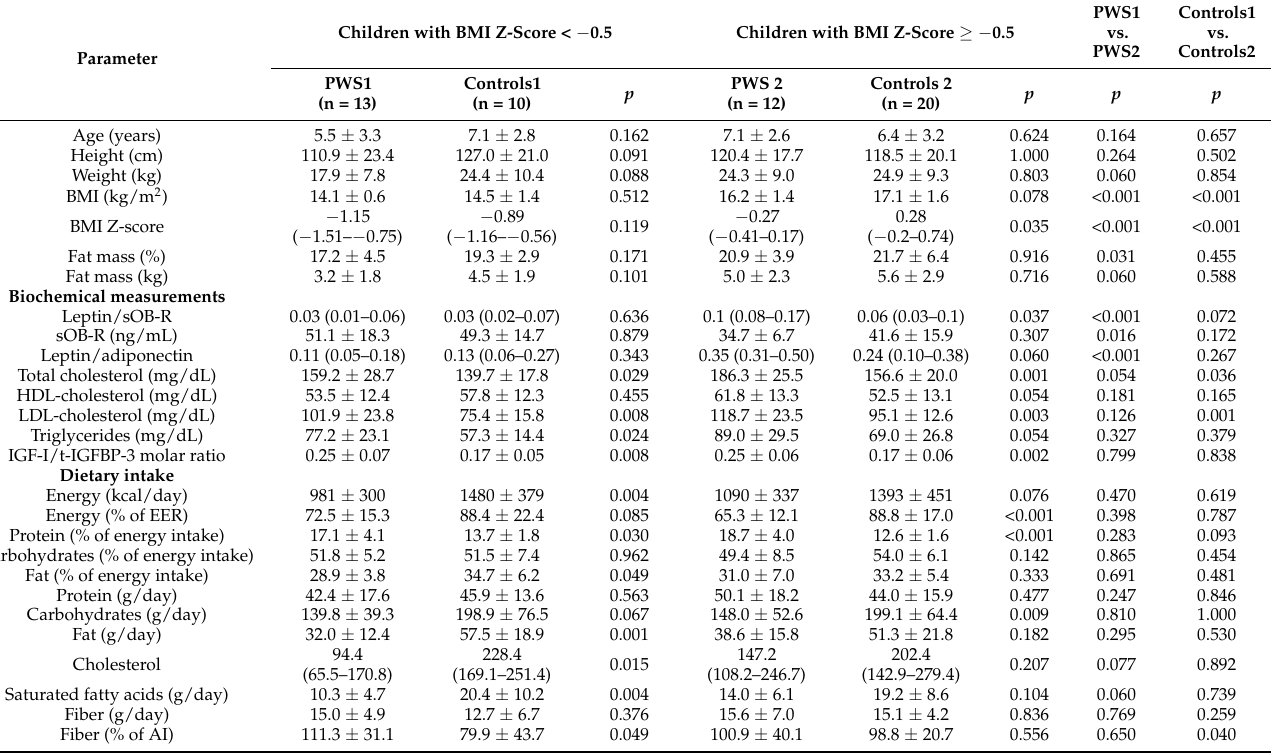
Table 3. Anthropometric and biochemical characteristics and dietary intake of PWS subgroups and their respective